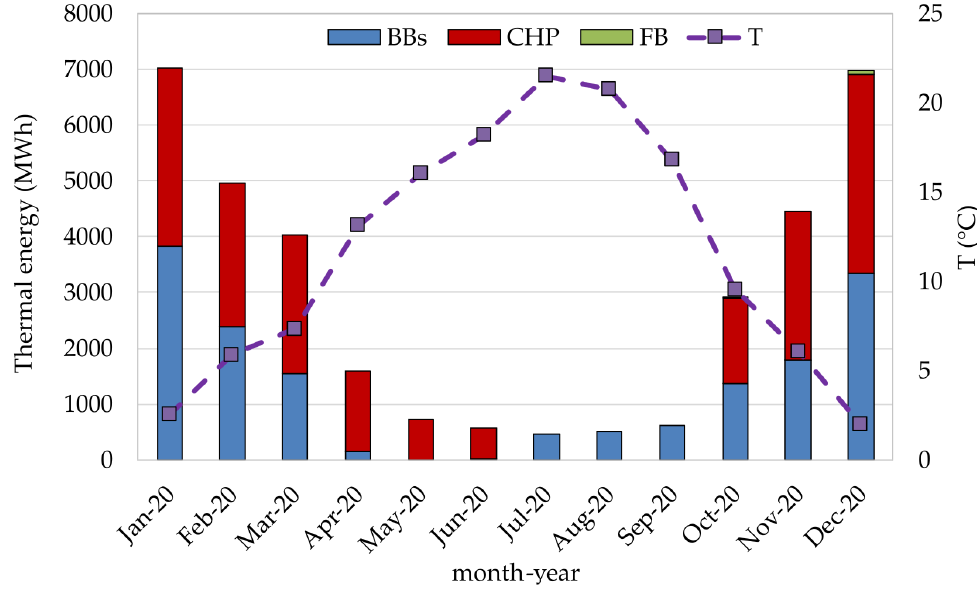
Figure 7. Thermal energy and average outdoor air temperature on a monthly